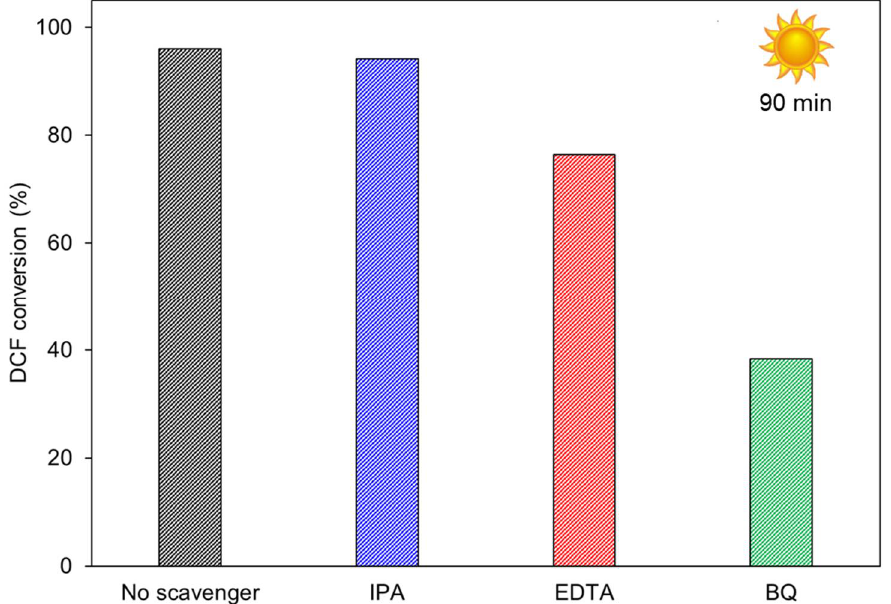
Figure 12. Effect of scavengers (IPA = isopropyl alcohol; EDTA = disodium ethylenediaminetetraacetic acid; BQ = p-benzoquinone) on the photocatalytic degradation of DCF by STOm (1.00 g·L −1 ) in UW.